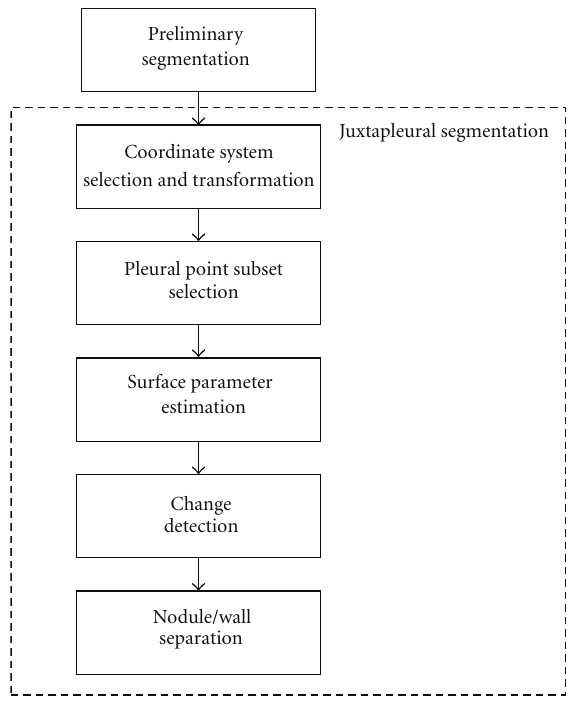
Figure 3: Flowchart overview of